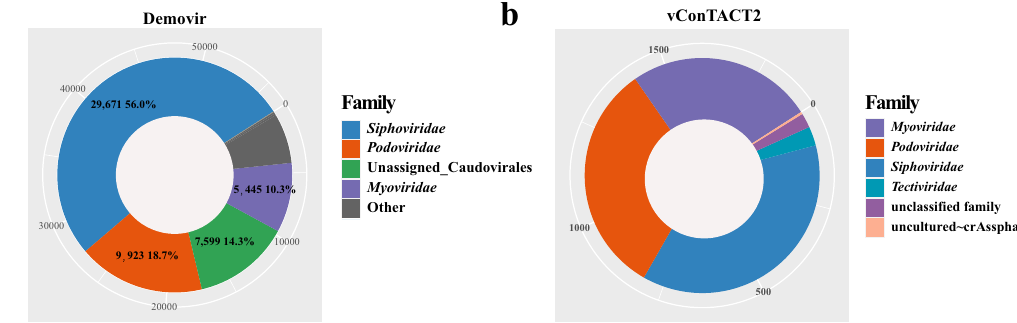
Fig. 1 | The taxonomic assignment of LVD. Pie charts showing the af fi liation of 56,870 vOTUs at family level assigned by script Demovir ( a ). and the af fi liation of 1864 vOTUs at family level assigned by package vConTACT2 ( b ). Source data are provided in the Source Data fi